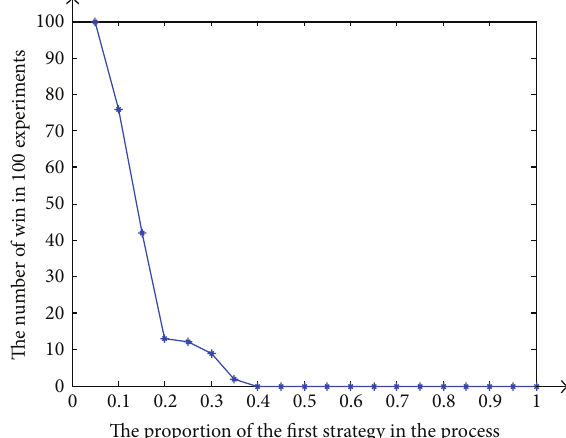
Figure 5: The Y-ray represents the number of win in 100 experi- ments. The X-ray represents the proportion of two strategies. There is linear increasing noise in the model.